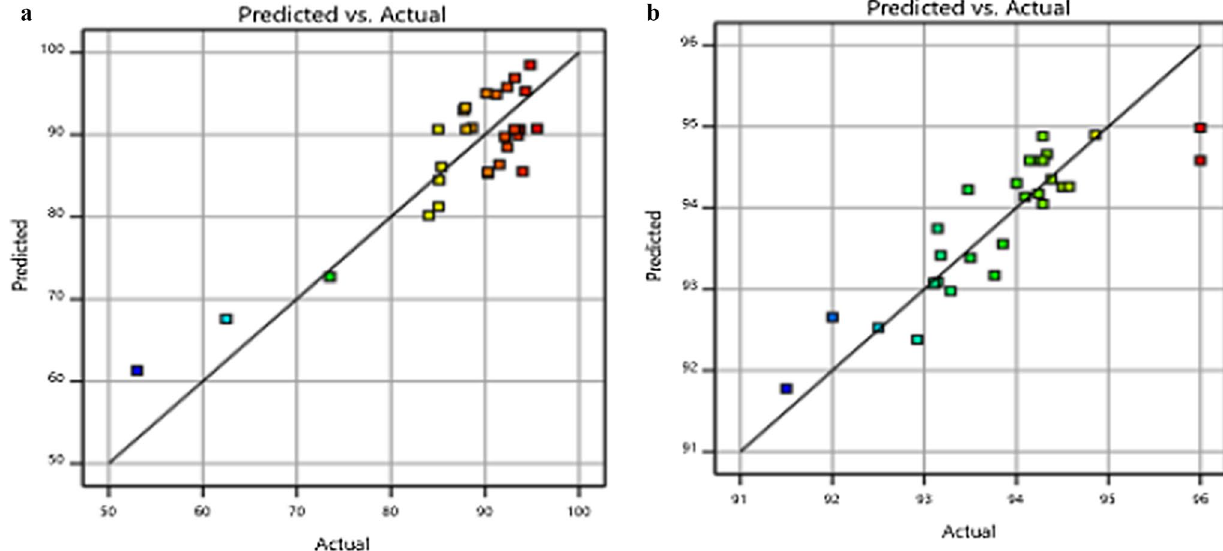
Fig. 4 Plots for predicted against actual results for fluoride removal a Al-EC, b